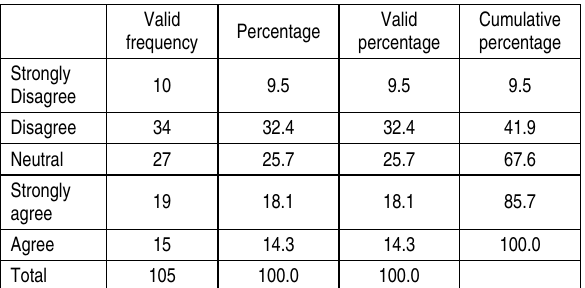
Table 8. Creating a tolerant environment